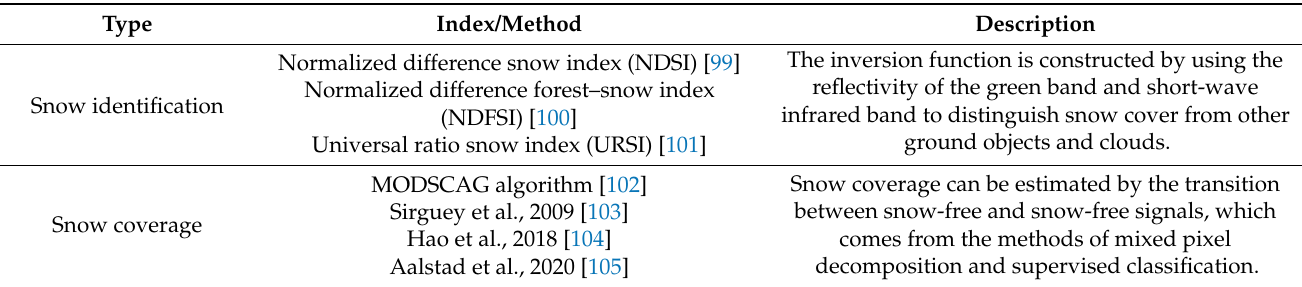
Table 4. Information extraction for precipitation.